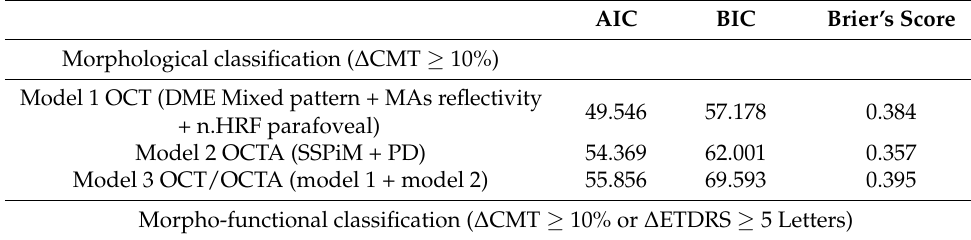
Table 2. Model’s comparing analysis. Morphological classification ( ∆ CMT ≥ 10%) Model 1 OCT (DME Mixed pattern + MAs